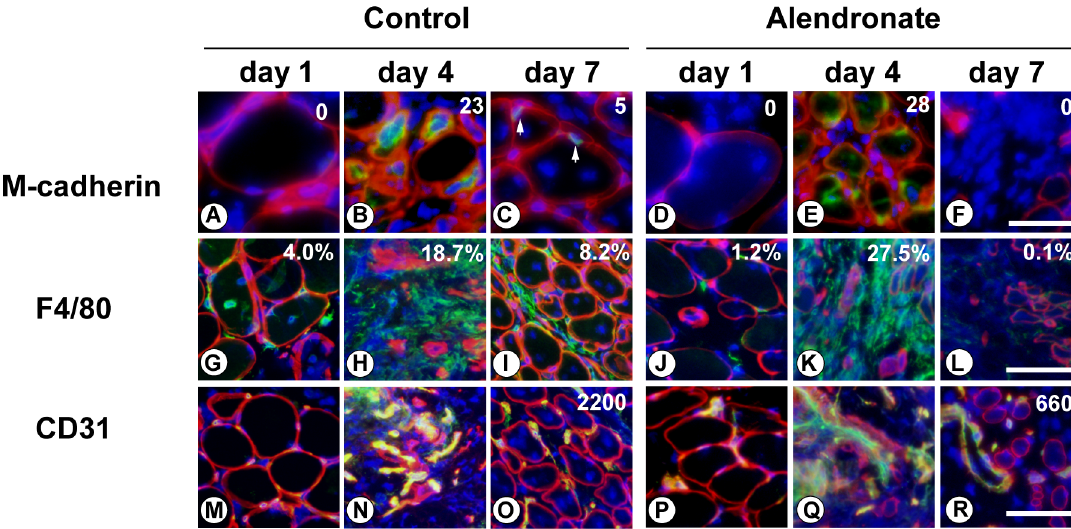
Fig 4. Combination of bone fracture and alendronate treatment causes loss of myogenic cells. PBS (Controlgroup) or alendronate(Alendronate group) was subcutaneously injectedthree times at seven-day intervals. The femur was broken and vastus lateralis muscle injuredby cold shock on day 14. Then the vastus lateralis muscle was removedon day 1, 4, or 7 after the bone fracture and cold injury. Sections were subjectedto immunostaining with antibodiesto M-cadherin (green in A-F), F4/ 80 (green in G-L), CD31 (green in M-R), and laminin α 2 (red in A-R). Nuclei were stainedwith DAPI (blue in A-R). Arrows represent M-cadherin-positivemuscle satellitecells in (C). Scale bars, 40 μ m in (A-F), 20 μ m in (G-R). Images represent a part of each originalpicture. Numbers represent numbers of M-cadherin-positivemuscle satellite cells/myogenic progenitorcells in each originalpicture (0.17 mm 2 ) in (A-F). Percentagesof F4/80-positive cell-occupied area of each originalpicture (0.68 mm 2 ) are shown in (G-L). Numbers of CD31-positive capillariesper mm 2 of each originalpicture are shown in (O and R).